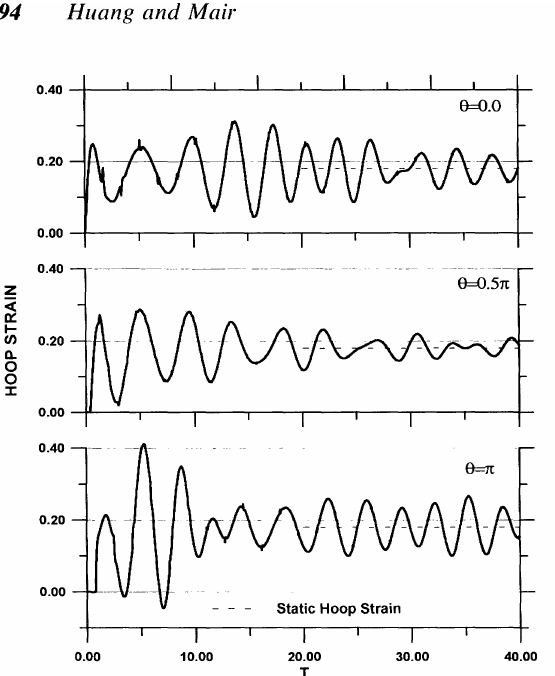
FIGURE 7 Time histories of 8,(0, T) due to a step incident wave.